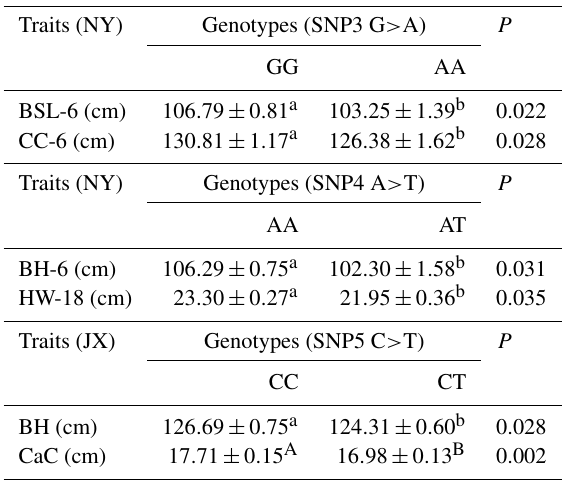
Table 6. The characteristics of three mutations in the Nanog gene in cattle. The numbers in the “traits” column indicate age in